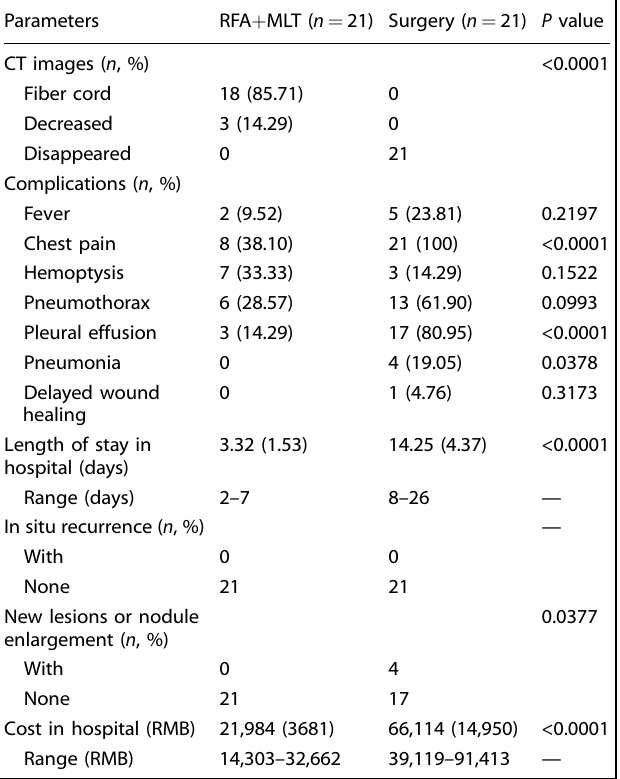
Table 2. Ef fi cacy, complications, and cost of patients in the RFA + MLT and surgery